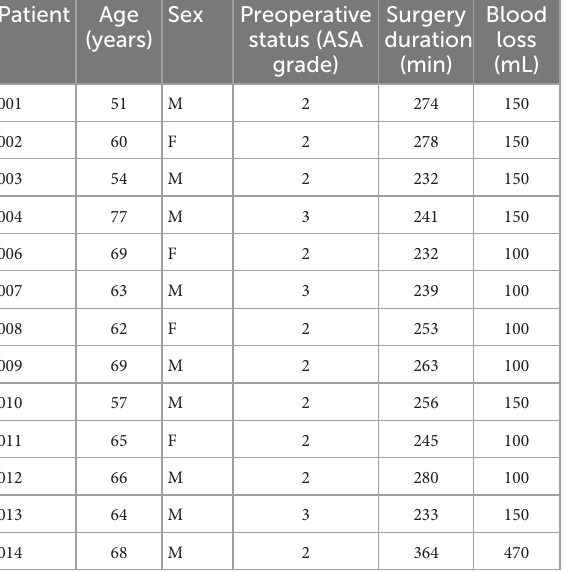
TABLE 1 Patient demographics and surgical